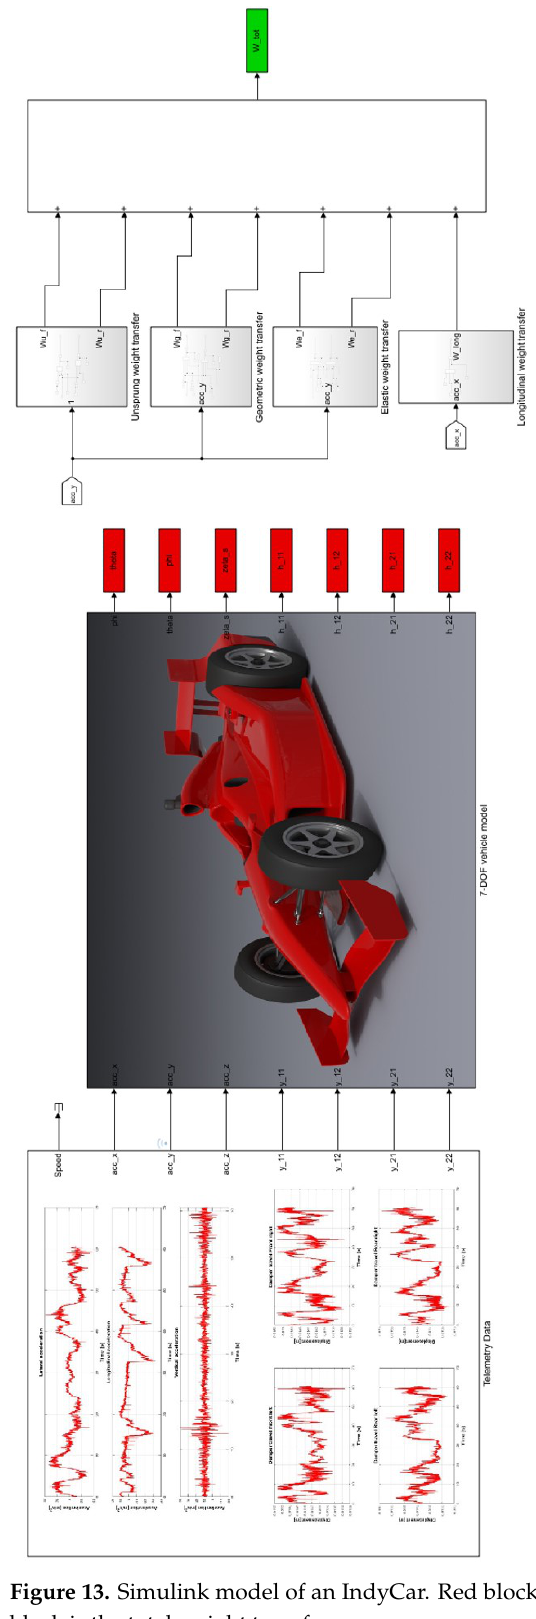
Figure 13. Simulink model of an IndyCar. Red blocks are the outputs of the model, and the green block is the total weight